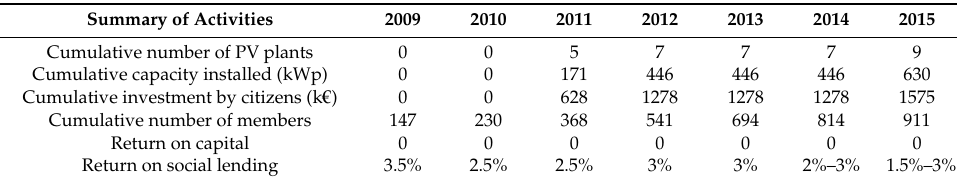
Table 2. Retenergie, summary of